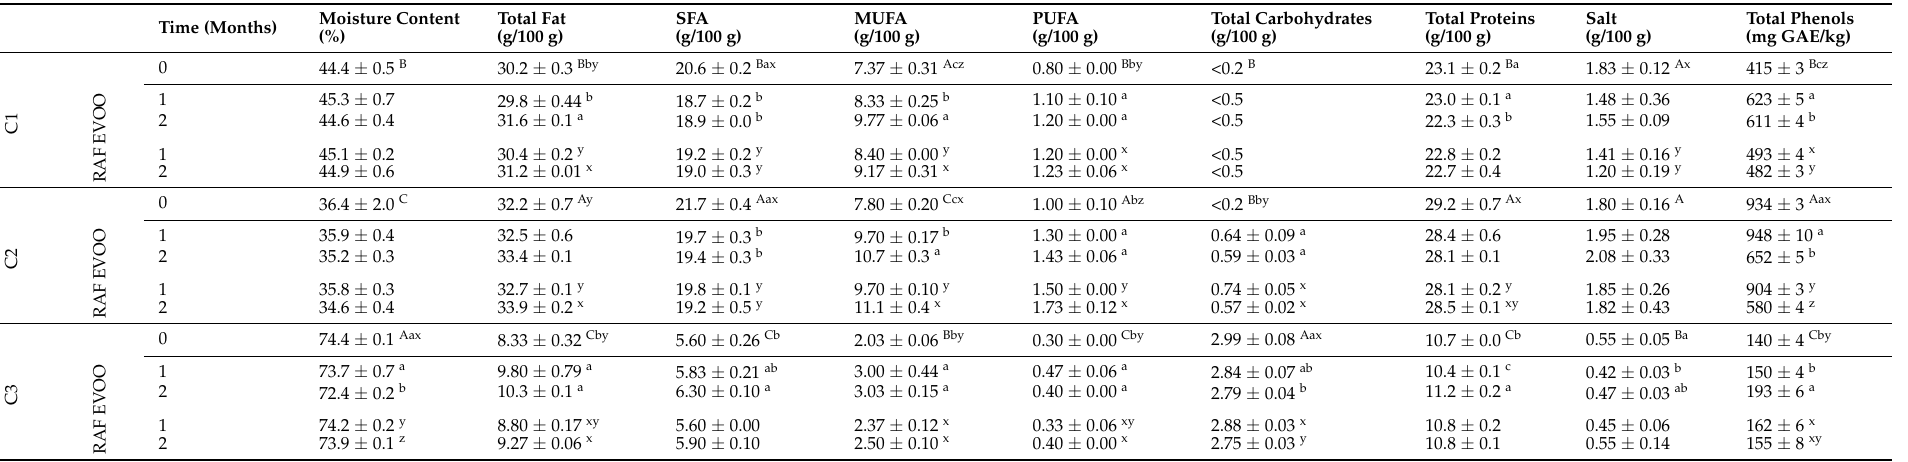
Table 2. Basic chemical composition of semi-hard (C1), hard (C2), and soft whey (C3) cheese during storage in extra virgin olive oil (EVOO) and refined olive oil